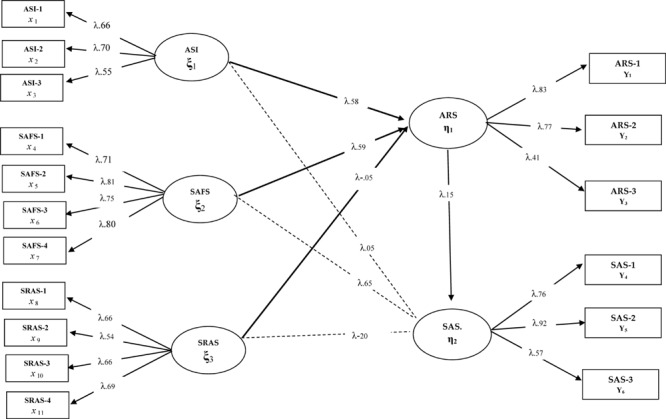
Standardized SEM results for Model 2.